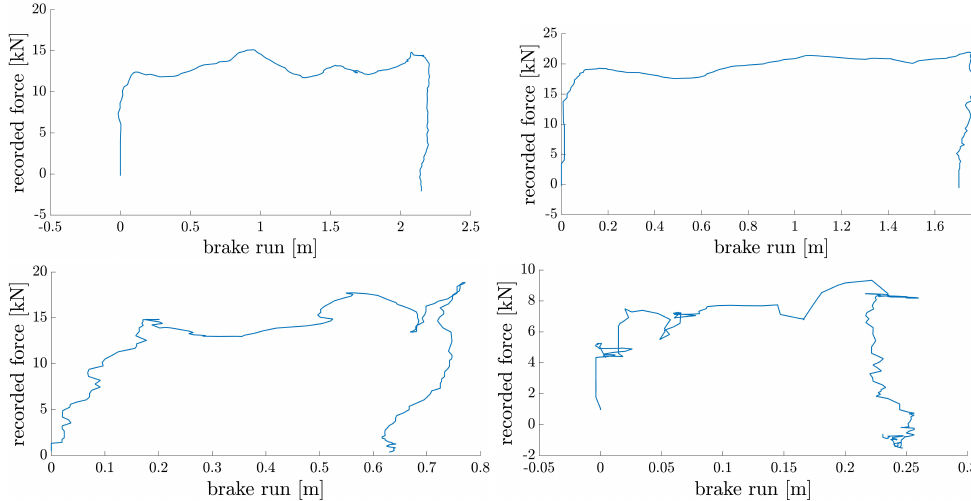
Figure 6. Four force–displacement diagrams used to determine brake-activation thresholds. For left to right and top to bottom : Off-centred impact, cable 3; off-centred impact, cable 1; lateral impact, cable 2; consecutive impact, cable 8. –pre-stress was taken into account.